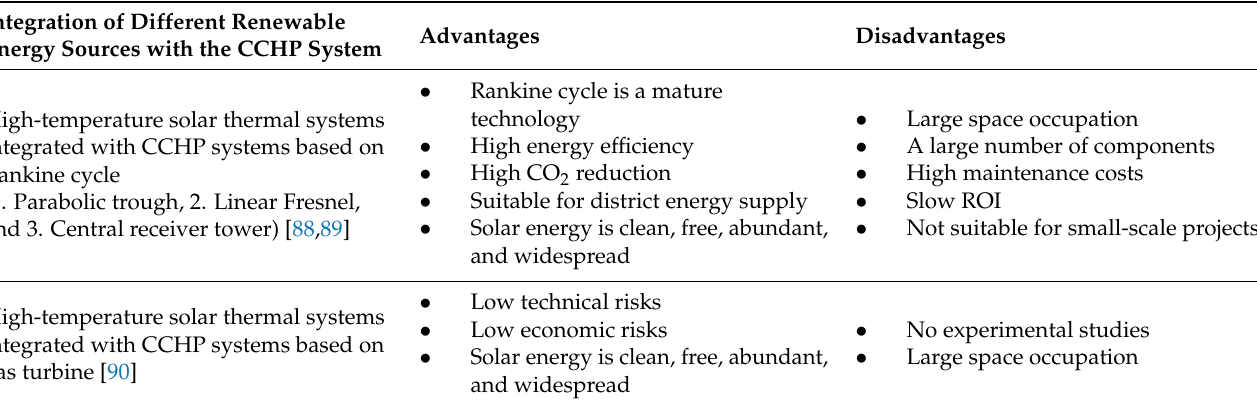
Table 4. Comparative table about the integration of the CCHP systems with different renewable energy